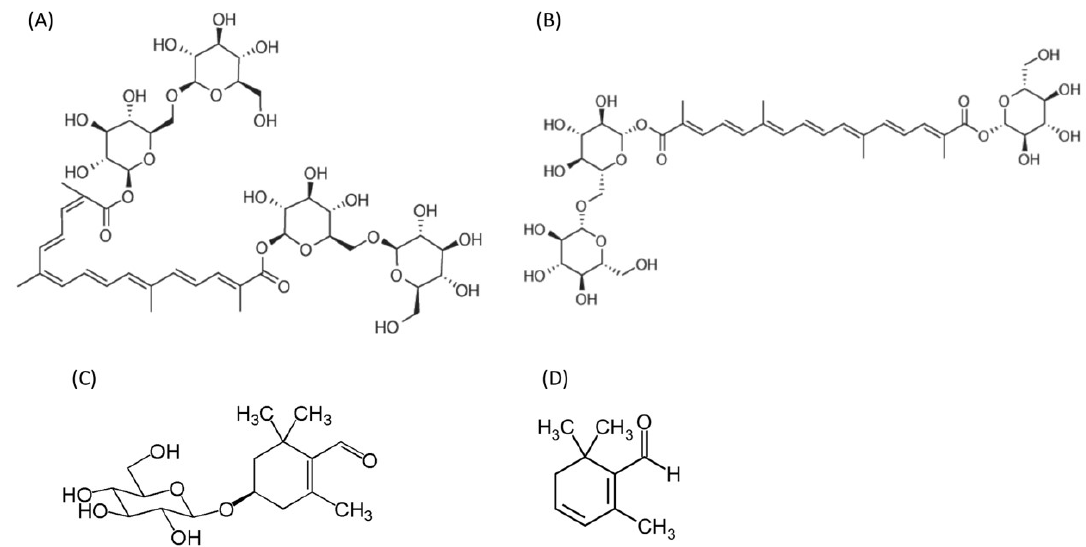
Figure 1. The chemical structure of the four major unique saffron ingredients. ( A ) Crocin and ( B ) crocetin are both are water-soluble carotenoid chemical compounds. ( C ) Picrocrocin is a monoterpene glycoside precursor of safranal ( D ).